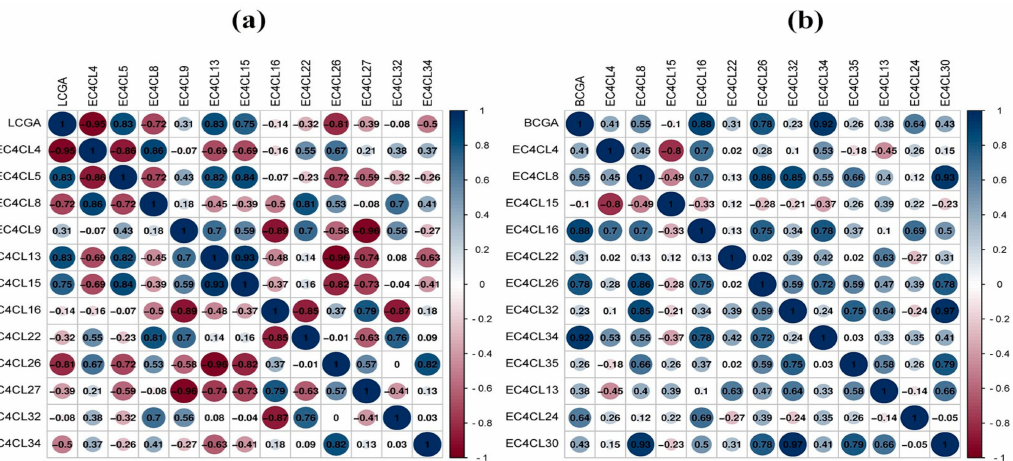
Figure 11. Correlation analysis of chlorogenic acid accumulation and Eu4CL expression in Eucommia ulmoides leaves ( a ) and bark ( b